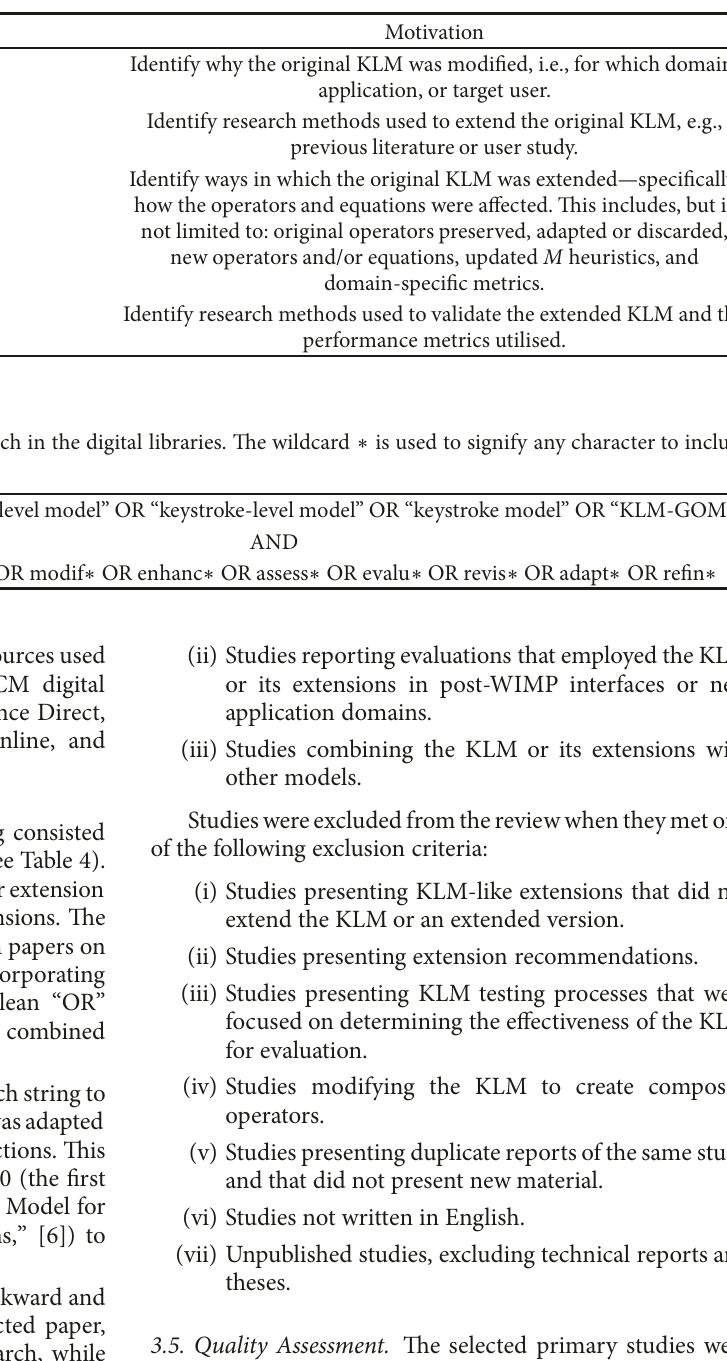
Table 3: Systematic review research questions and their motivations.